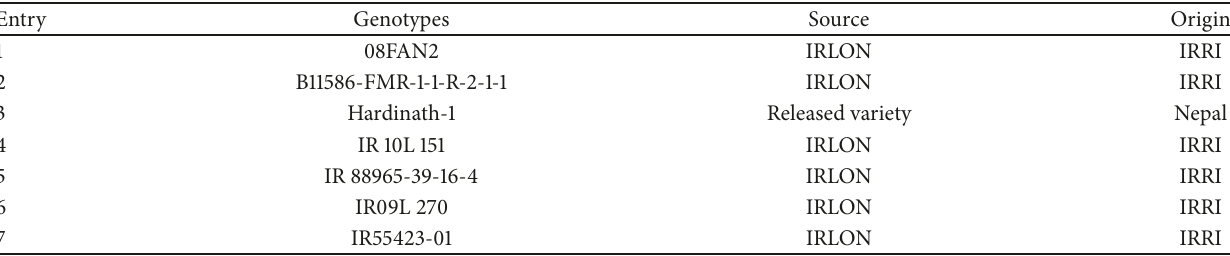
Table 1: Descriptions of rainfed lowland early rice genotypes tested at different locations during 2015 and 2016. ( ∗ NRRP, Hardinath, RARS, Khajura, NMRP, Rampur and NWRP, Bhairahawa) of